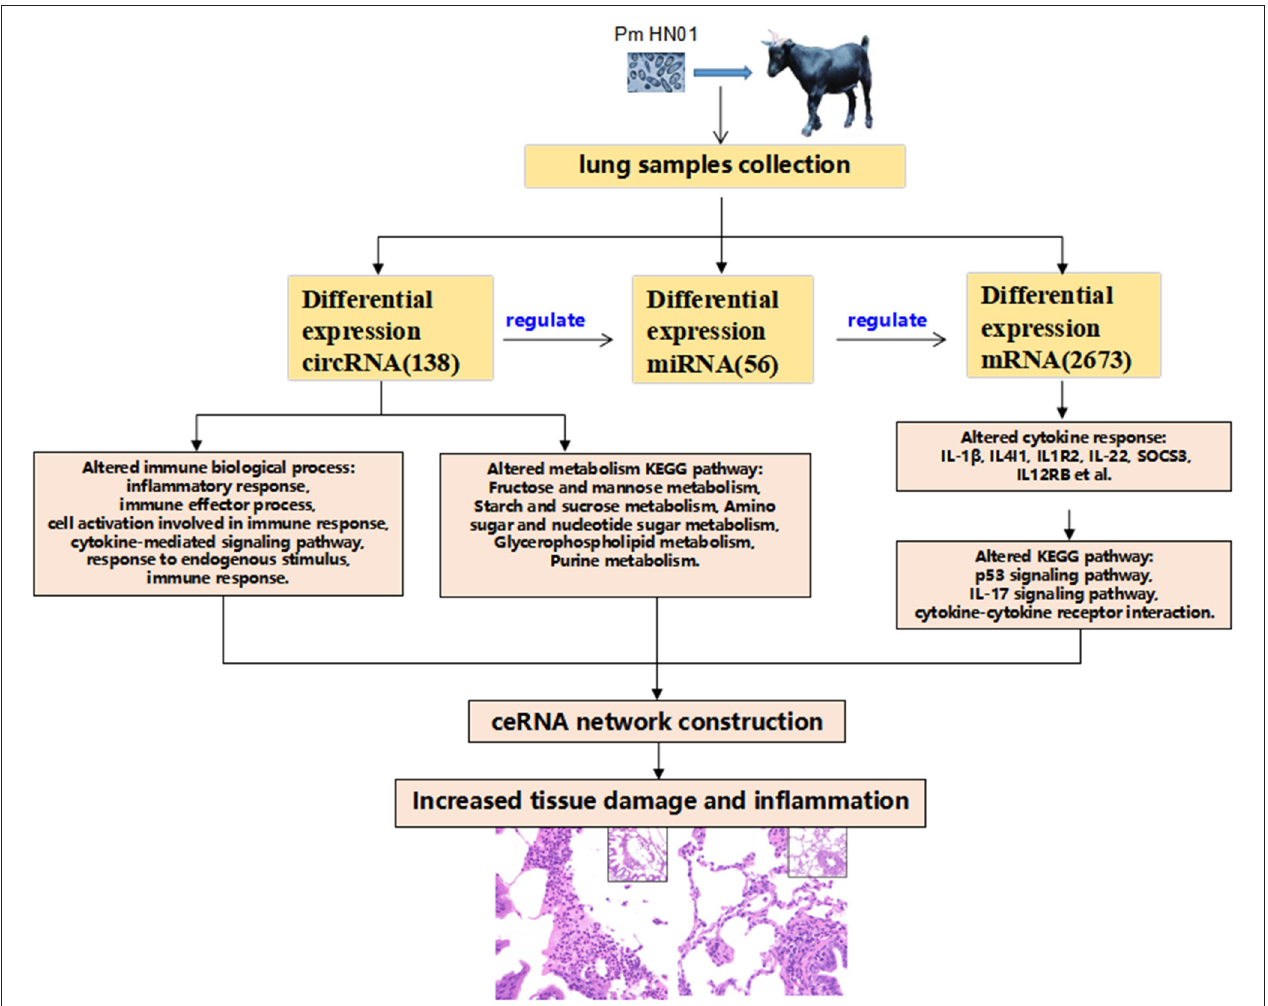
FIGURE 6 | Schematic overview of the study results. P. multocida was used to challenge goats, which caused pathological changes in tissues. After transcriptome sequencing with the lungs, the transcriptome expression level of lung tissues were changed significantly. Differentially expressed circRNAs were involved in host immunology biological processes and metabolic pathways. circRNAs function as a miRNA sponge, regulated the expression of miRNAs, and miRNAs regulated a wide range of target genes forming the circRNA–miRNA–mRNA regulating network. A large number of differentially expressed cytokines [interleukin-1beta (IL-1 β